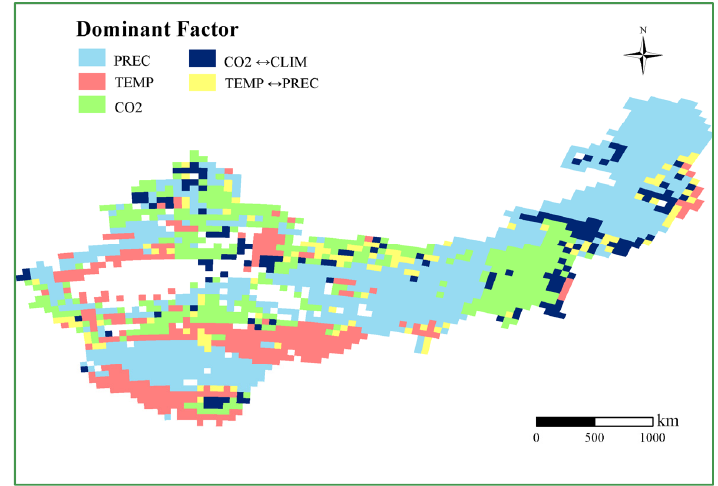
Figure 7. The spatial distribution of the dominant factor that controlled the NPP dynamic in ASA ‐ China.